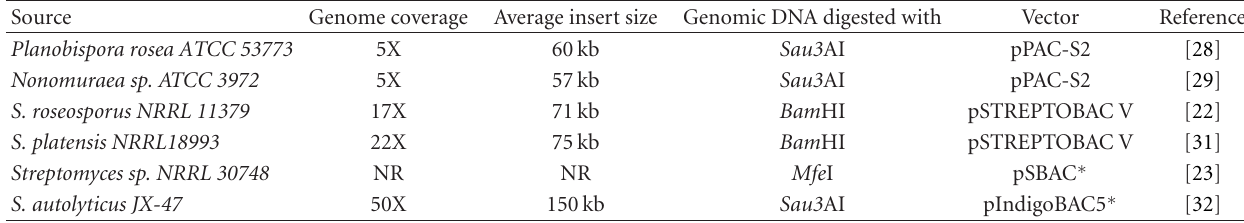
Table 2: Actinomycetes genomic libraries constructed in artificial